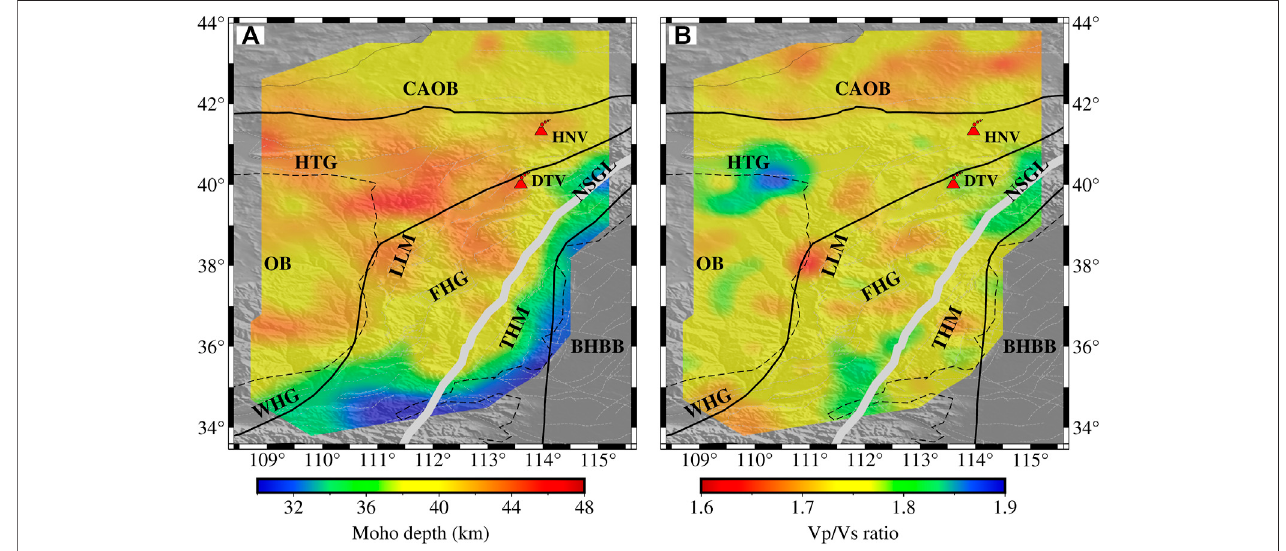
FIGURE 4 | Maps show the Moho depth (A) and Vp/Vs ratio (B) in this study. The abbreviations are the same as those de fi ned in the caption of Figure 1 .